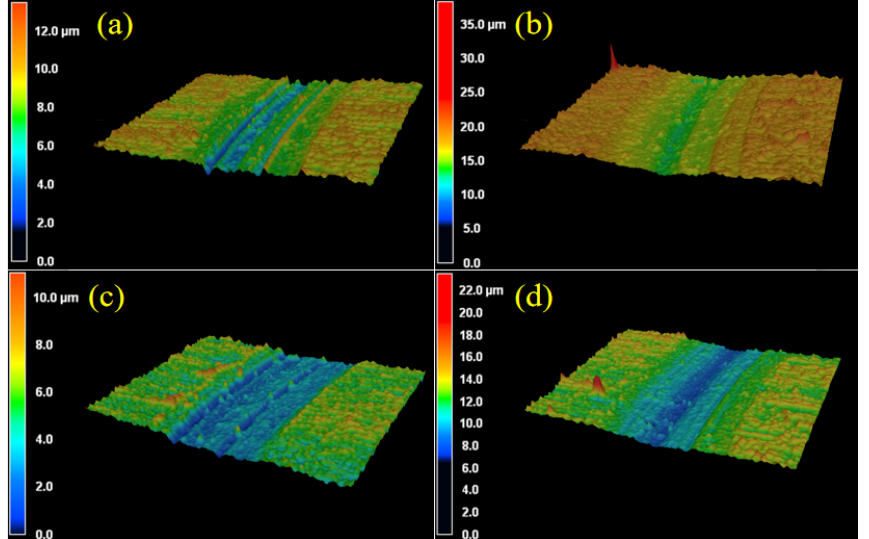
Figure 6. Three-dimensional laser confocal images of the wear tracks with different heat treatment processes under the conditions of wear load 20 N and wear time 5 h. ( a ) QP; ( b ) QPT; ( c ) MQP; ( d ) MQPT.